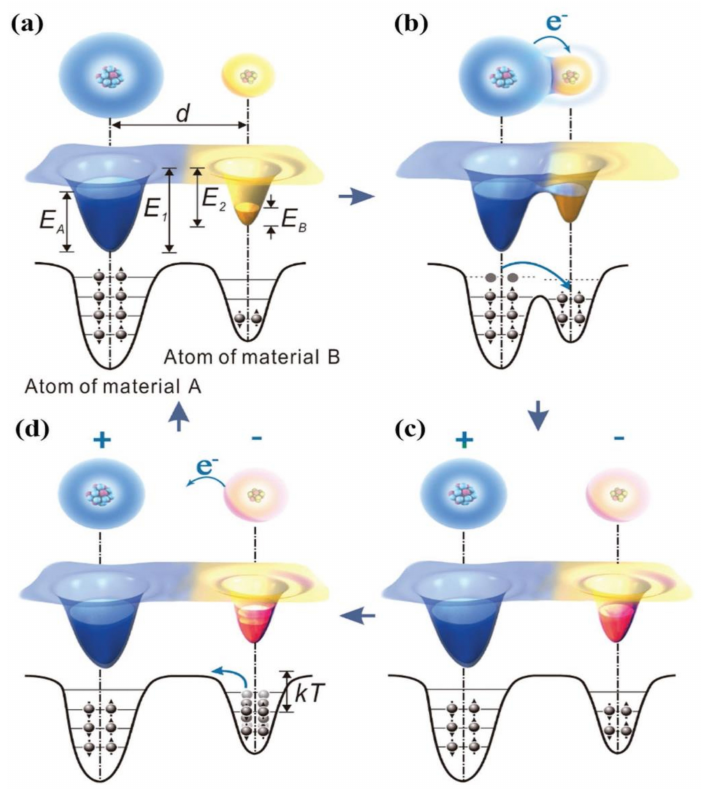
Figure 1. An electron cloud model for contact electrification between two materials ( a ) before contact, ( b ) in contact, ( c ) after contact, and ( d ) the charge release from the atom (reproduced with permission from [66] Copyright 2018 WILEY-VCH Verlag GmbH & Co. KGaA, Weinheim,